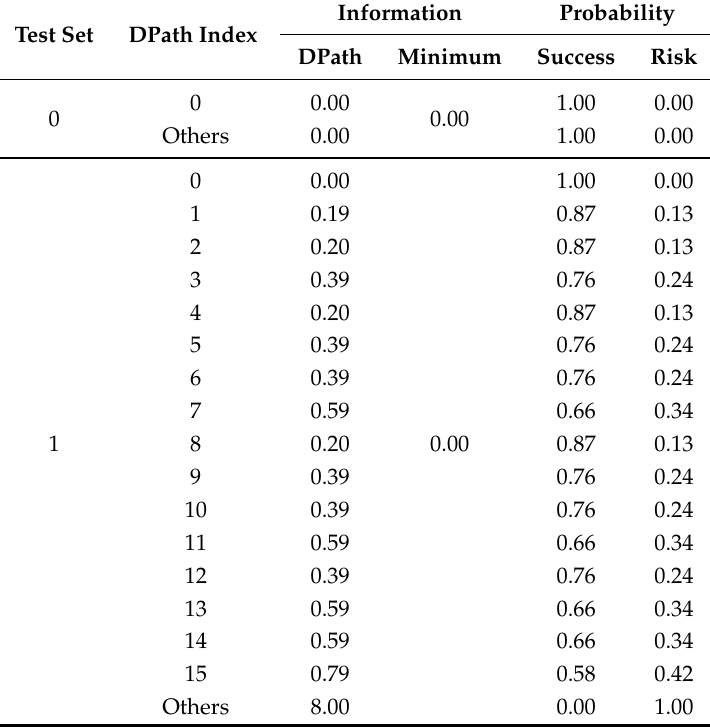
Table 4. DPath success and risk probabilities for DSpace traversals using Test Sets 0 and